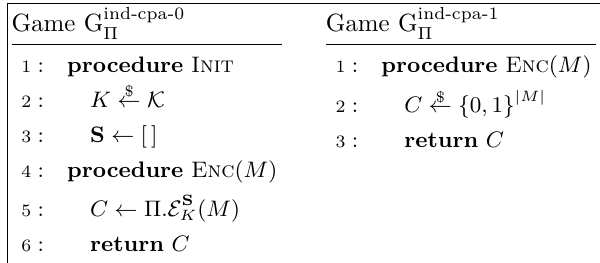
Figure 1: Games defining semantic security of an LPSE scheme